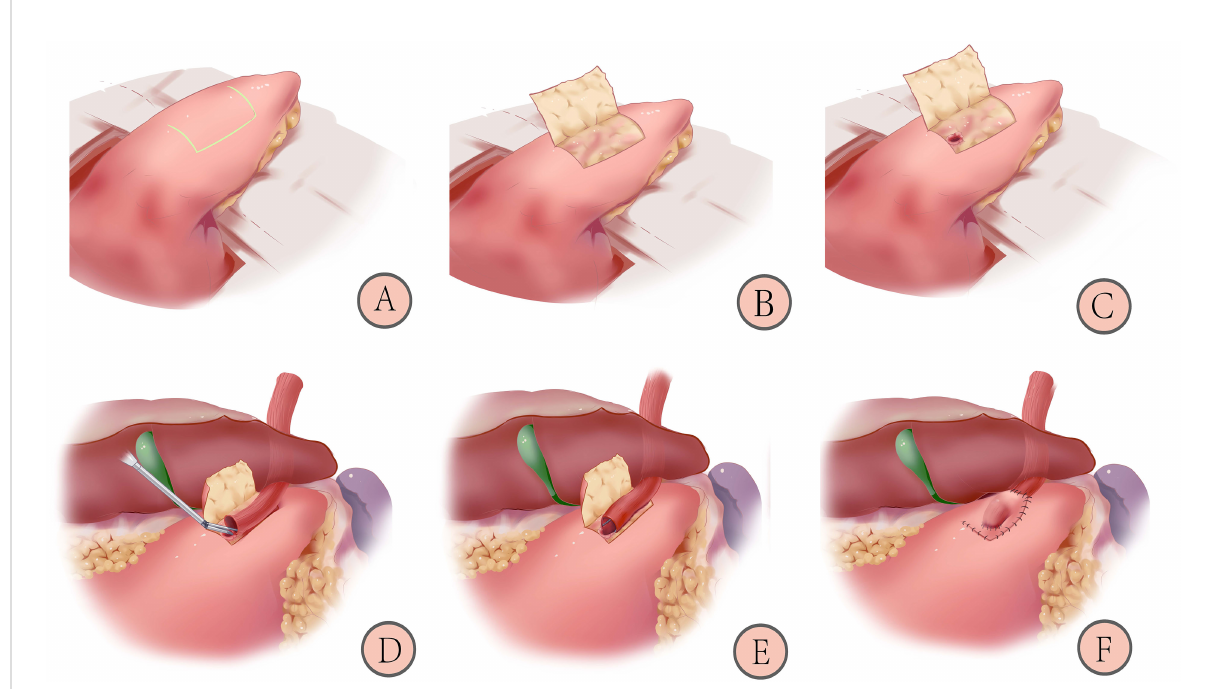
FIGURE 2 Schematic diagram of reconstruction after proximal gastrectomy with left-open single- fl ap technique: 1) Marking the “ ⊐ ” -shaped mucosal window (A) ; 2) Making the left-open single- fl ap (B) ; 3) Fixing the esophagus and opening a gastric mucosal window (C) ; 4) Anastomosing by linear staplers (D) ; 5) Closing of the common opening with barbed wire (E) ; 6) Covering the left-open single- fl ap and suturing with barbed wires (F)